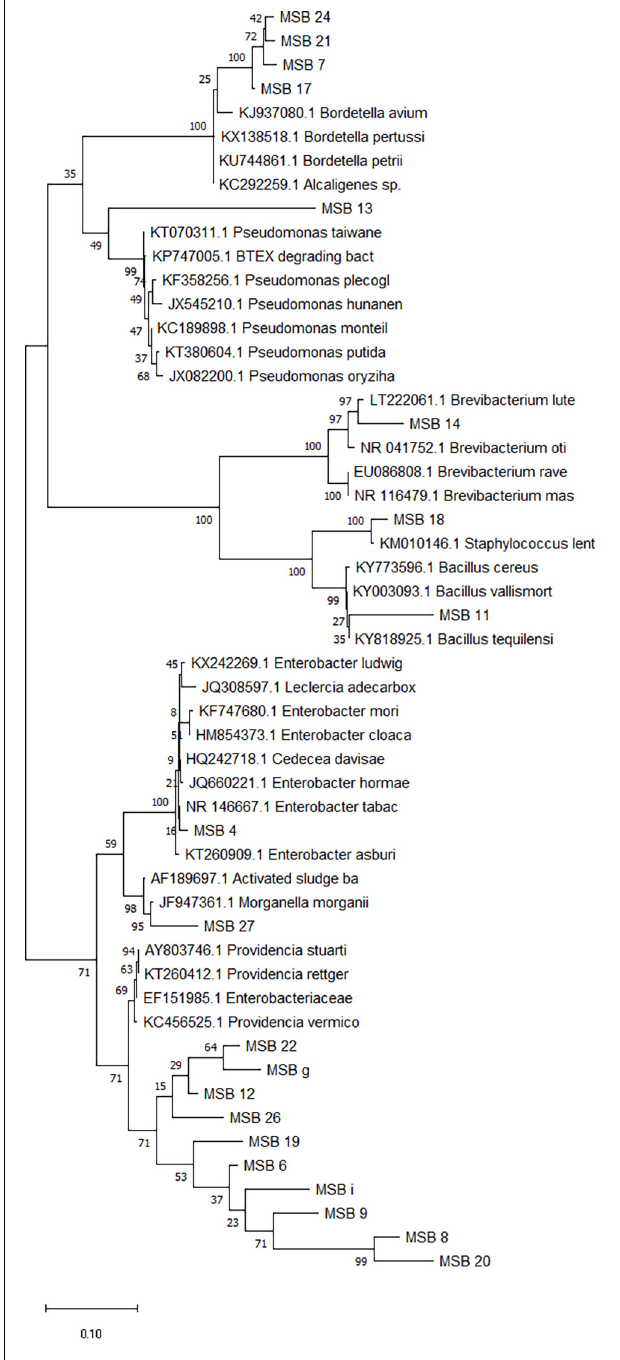
FIGURE 2 | Phylogenetic tree by Maximum Likelihood Method showing the evolutionary relationships of bacterial isolates from chicken manure (CM) and kitchen waste (KW) fed black soldier fly larvae (BSFL) and isolates from GenBank.